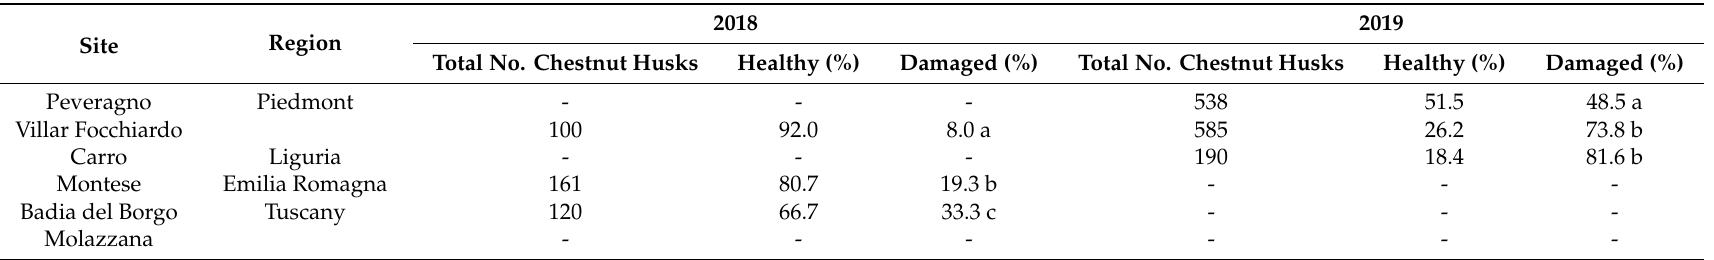
Table 3. Total number of chestnut husks collected per site and region, and percentage of healthy and damaged husks recorded in the two-year period 2018–2019. Site